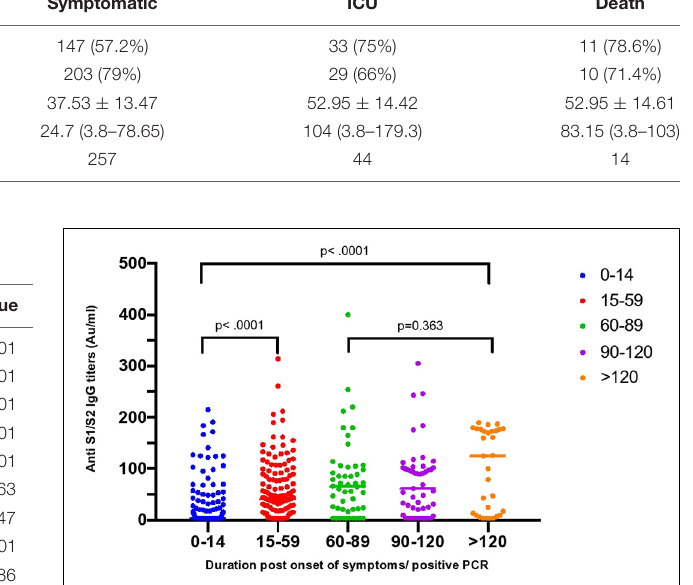
FIGURE 1 | Distribution of SARS-CoV-2 anti S1/S2 protein IgG titers overtime. Grouped scatter plot showing significantly higher anti S1/S2 IgG titers in samples collected > 14–59 days compared to samples collected ≤ 14 days post symptoms or positive PCR ( p < 0.0001). The difference was also maintained in samples taken > 120 days compared to ≤ 14 to ≤ 14 days ( p < 0.0001). No significant difference in titers of samples collected between 60 and 89